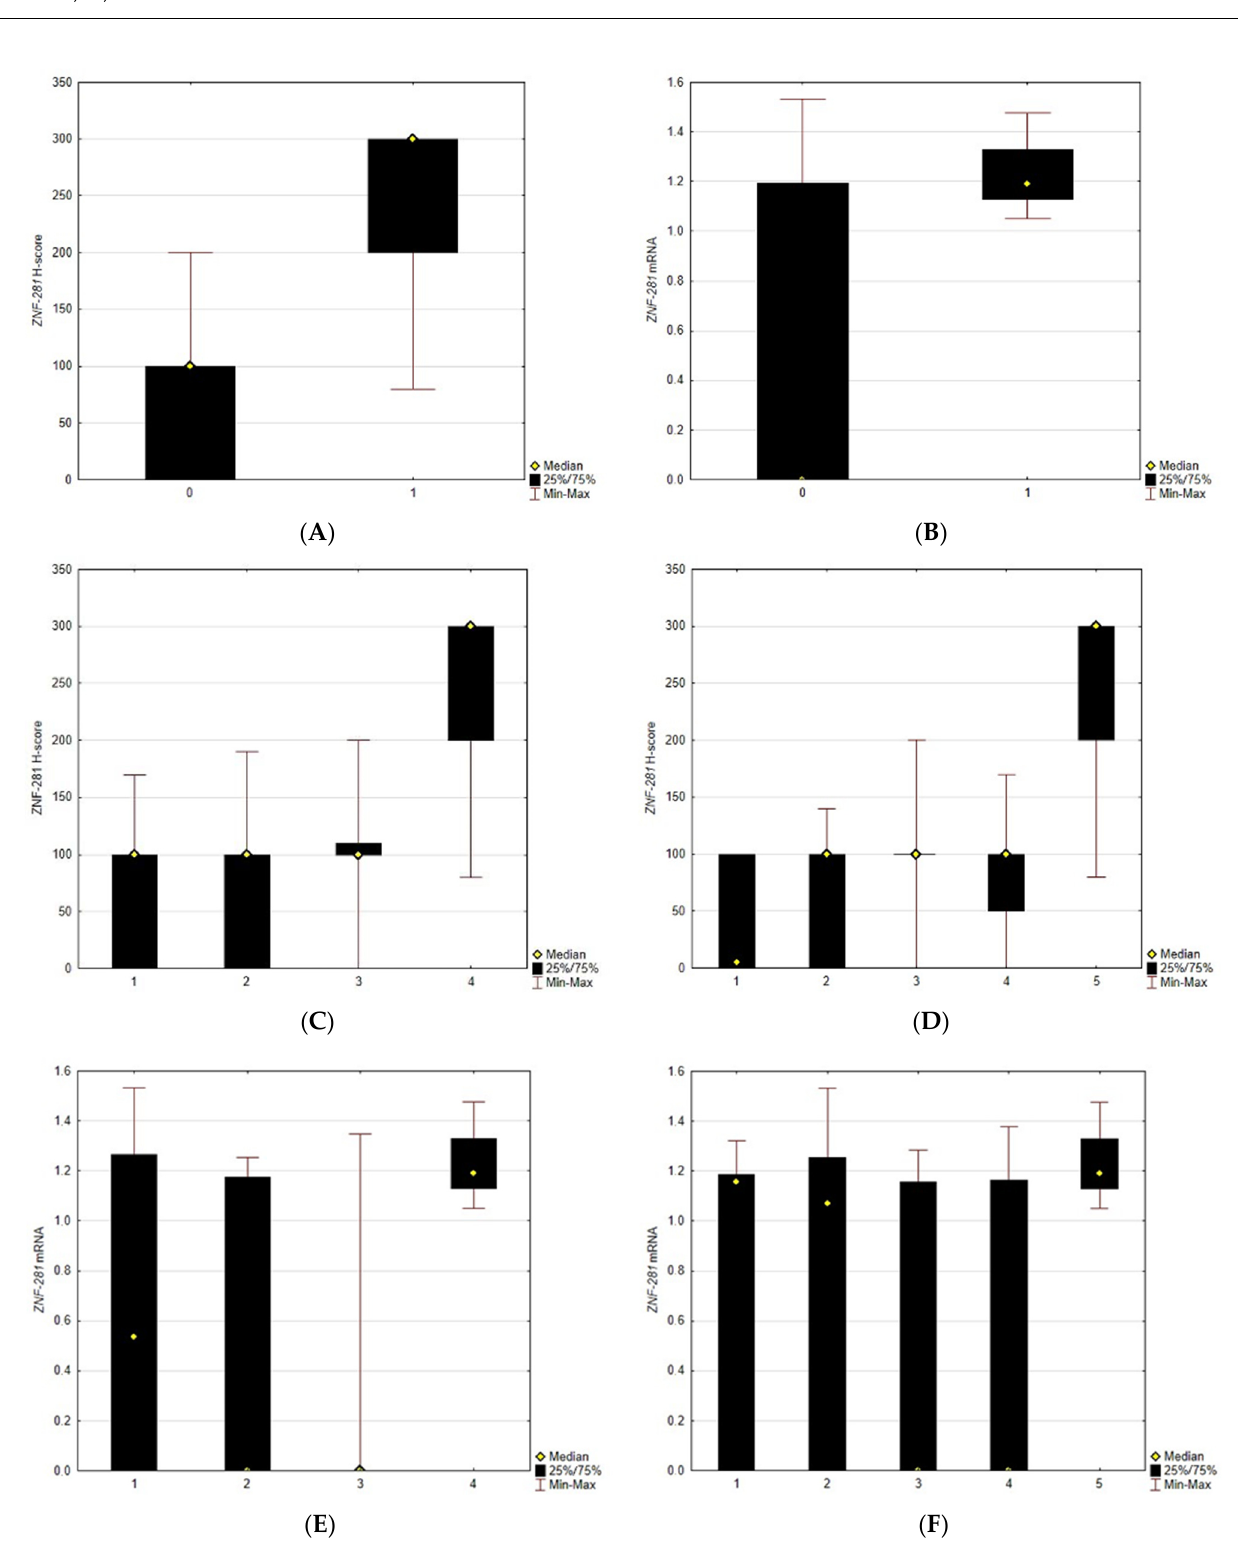
Figure 2. ( A ) Comparison of ZNF-281 H-score between OSCC and control, p < 0.001. ( B ) Comparison of ZNF-281 mRNA transcript level between OSCC and control, p = 0.0011. ( C ) Comparison of ZNF-281 H-score in grades (1–3) and control. ( D ) Comparison of ZNF-281 H-score level in stages (1–4) and control. ( E ) Comparison of ZNF-281 mRNA level in grades (1–3) and control. ( F ) Comparison of ZNF-281 mRNA level in stages (1–4) and control.